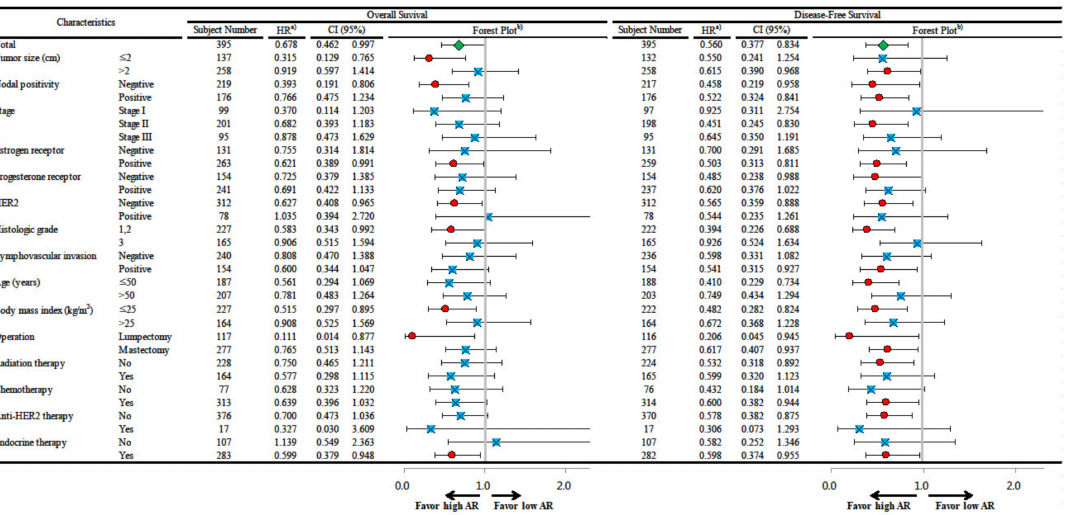
Figure 2. Subgroup analysis of the Cox proportional hazards model according to the expression level of AR (proportion score with the cut-o ff value of 10%) regarding overall survival and disease-free survival. Abbreviation: AR, androgen receptor; CI, confidence interval; HER2, human epidermal growth factor receptor 2; HR, hazard ratio. a) HRs are the relative risks of the high AR group (proportion score > 10%) with reference to the low AR group (proportion score ≤ 10%) by Cox proportional hazards model. b) In the forest plot, an HR value of less than 1 favors the high AR group against the low AR group. The red circles mean statistical significance and the blue squares mean no statistical significance. The green diamond means the result of total